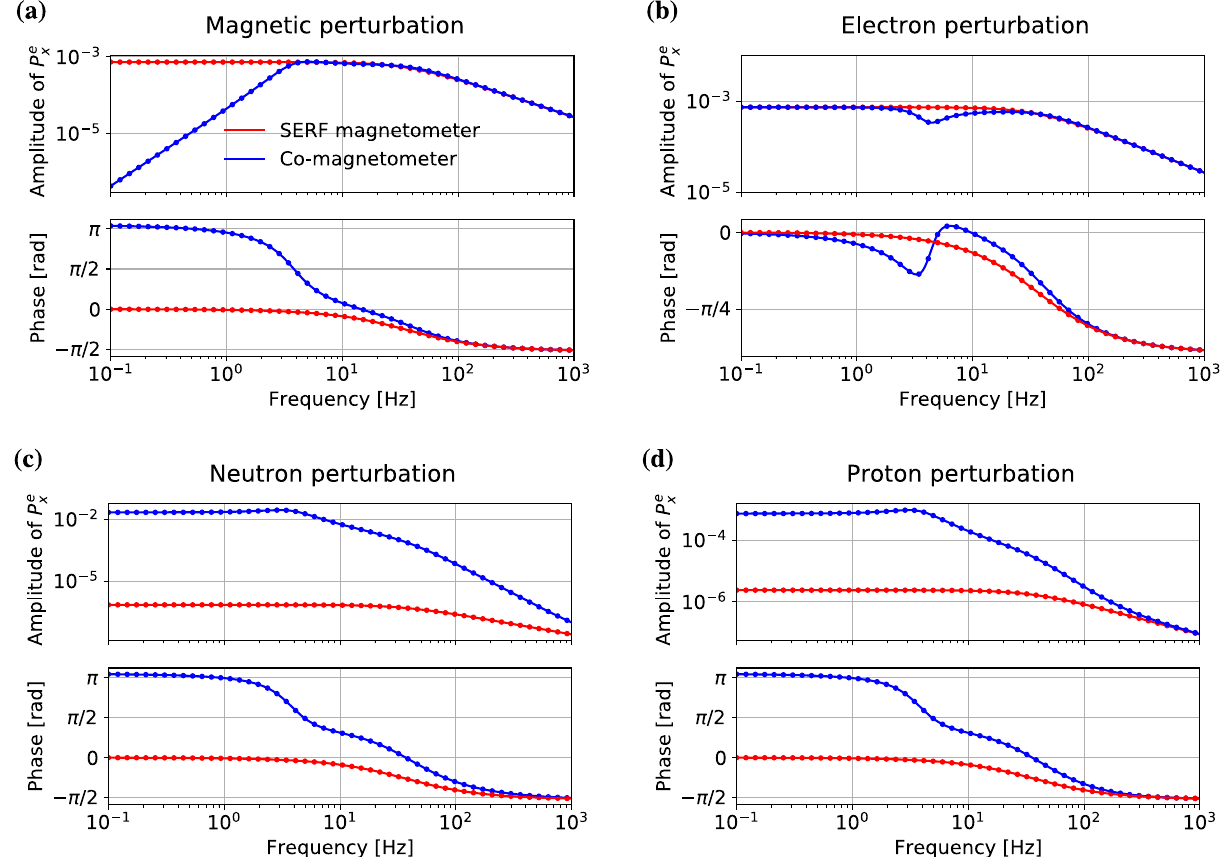
Figure 1. Numerically calculated (dots) and theoretically simulated (lines) amplitude and phase responses of the SERF (red) and co-magnetometer (blue) magnetic (a) , electron nonmagnetic (b) , neutron nonmagnetic (c) , and proton nonmagnetic (d)